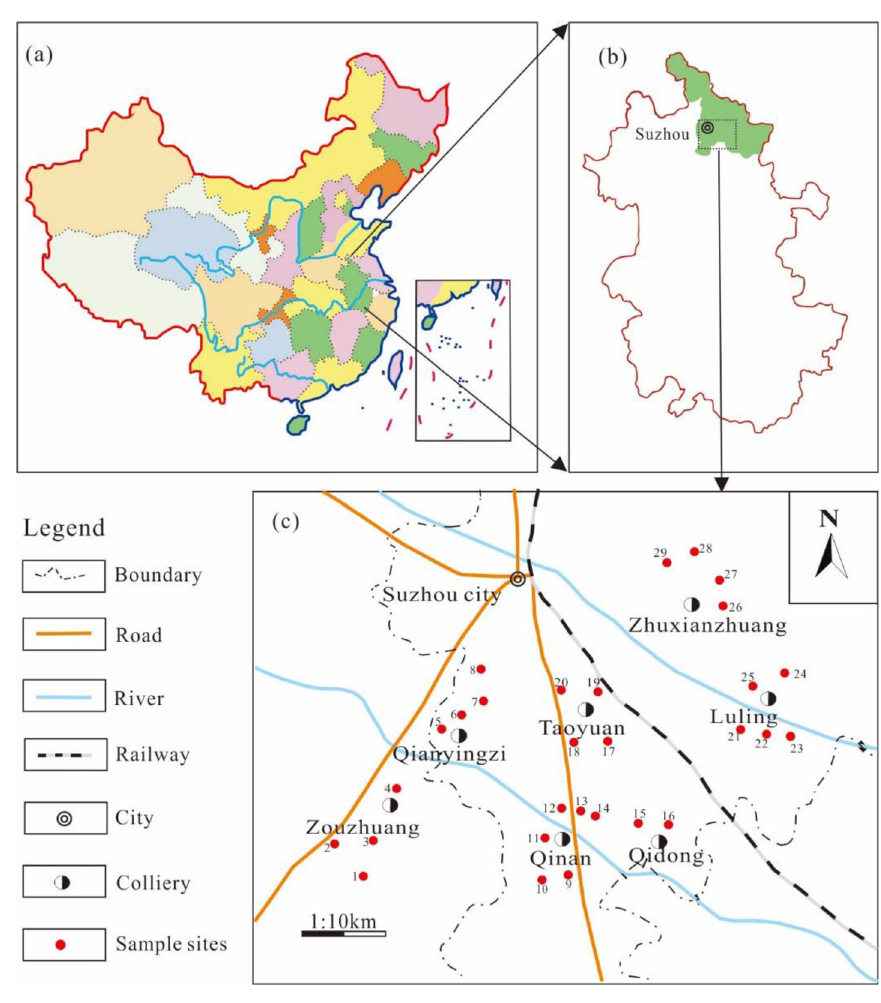
Fig. 1 Study area and sampling locations Table 1 Relative weights of the various shallow groundwater